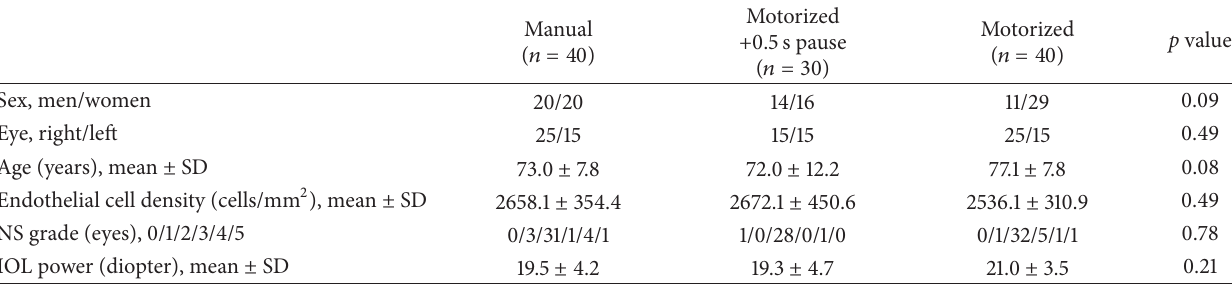
Table 1: Preoperative demographic data for the patients.